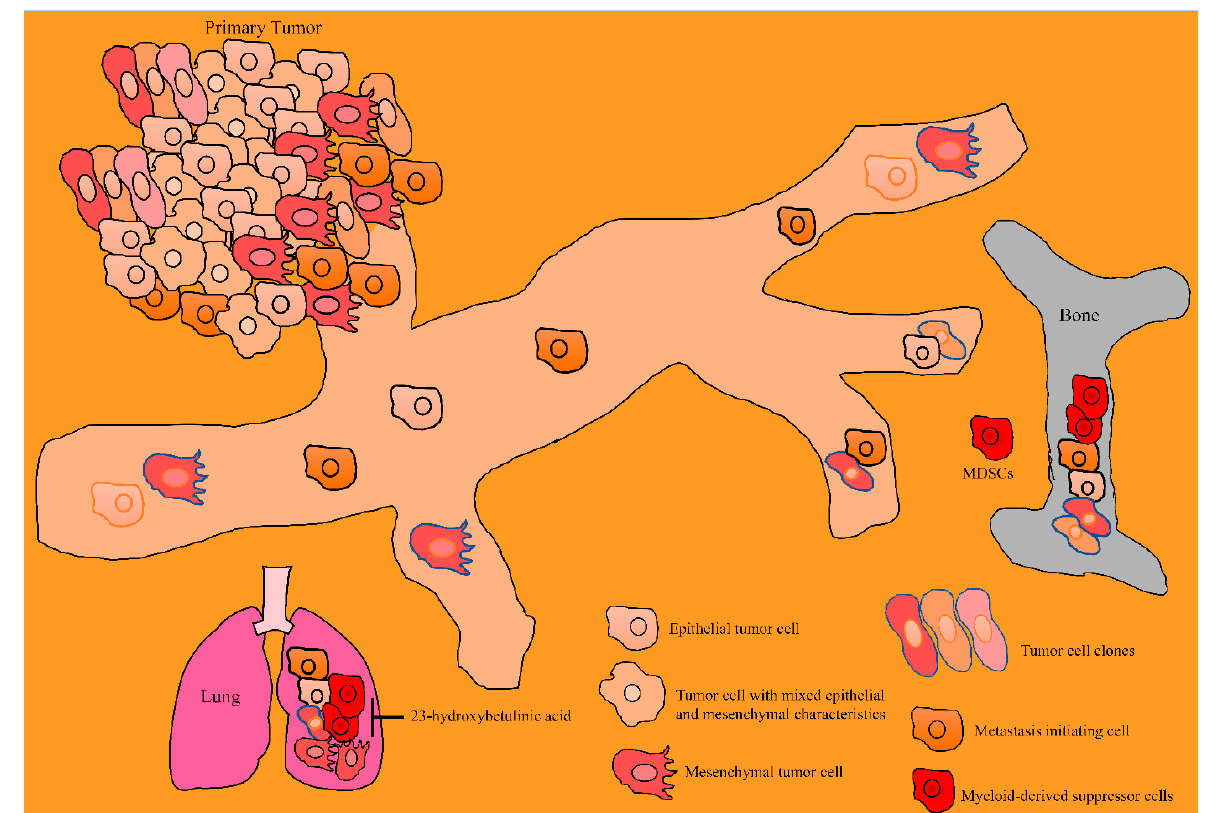
Figure 4. Betulinic acid mediated inhibition of invasion and colonization of cancer cells to the distantly located organs. Cancer cells from the primary tumors are metastatically competent and invade bones and lungs for colonization. Betulinic acid attenuated the invasion and colonization of cancer cells to the bones and lungs. Abbreviations: Myeloid-derived suppressor cells (MDSC), Matrix metalloproteinases (MMPs), Tissue Inhibitor of Metalloproteinase (TIMP).